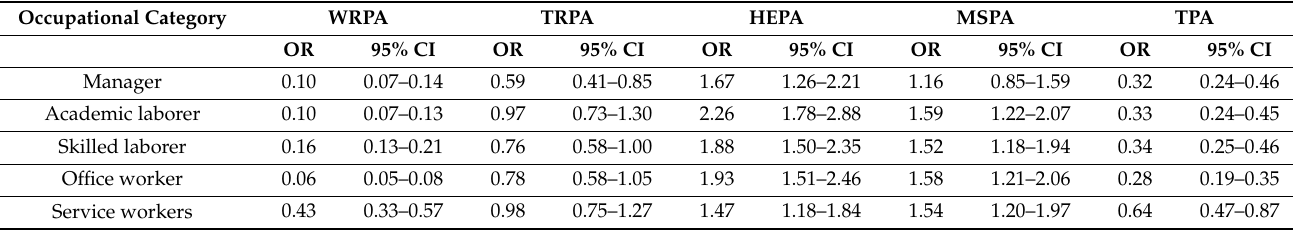
Table 4. Factors associated with physical activity in different domains: Results of multivariate binary logistic regression model, all factors mutually adjusted for each